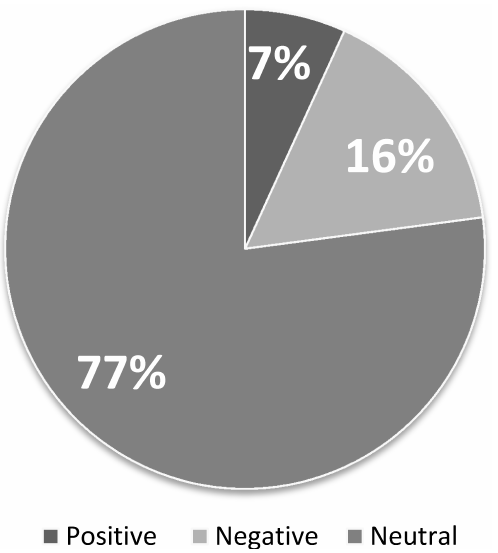
Figure 3. Classification of Lower House election tweets into positive, negative, and